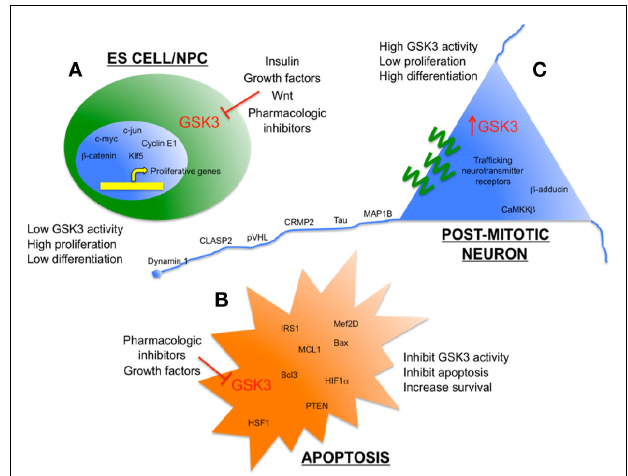
FIGURE 1 | Glycogen synthase kinase 3 as an enzymatic sensor for determining cell fate in the brain. (A) Low levels of GSK3 activity in ES cells/NPC’s are maintained by persistent growth factor/Wnt signaling to promote proliferation. Some pro-proliferation transcription factors that are direct targets of GSK3 are shown. (B) Low levels of GSK3 activity inhibit apoptosis and promote survival when cells are exposed to toxic stimuli, such as hypoxia and amyloid peptides. Some pro-survival substrates of GSK3 are shown. (C) Relatively high levels of GSK3 activity help to promote differentiation and efficient function of mature, post-mitotic neurons, including several cytoskeleton-associated proteins that maintain neuronal morphology and